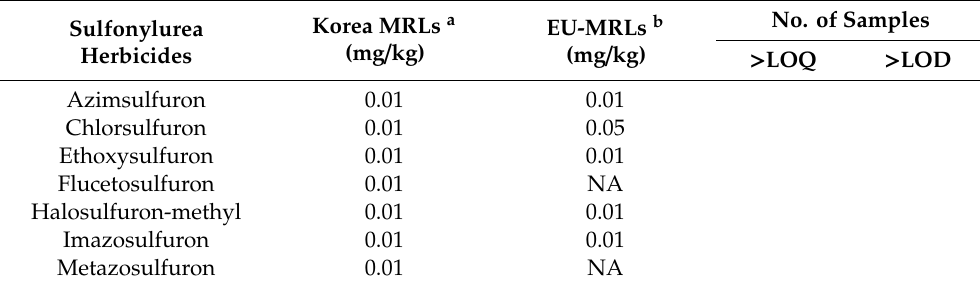
Table 4. Applying the d-SLE method to ten strawberry samples.